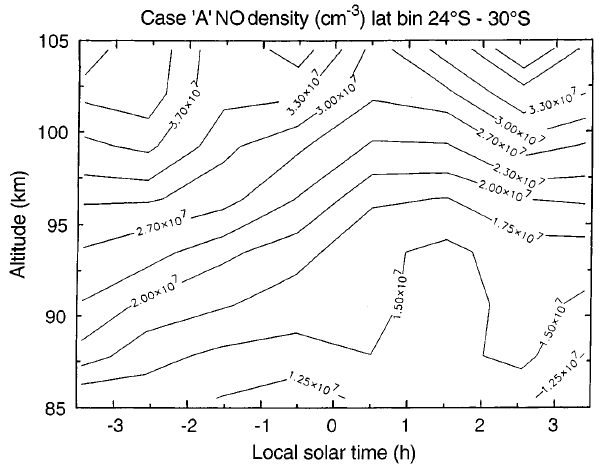
Fig. 5. A contour plot of the nitric oxide densities derived from the WINDII continuum measurements using the case A coe(cid:129)cients for the latitude bin 30 (cid:176) S to 24 (cid:176) S as a function of local solar time and altitude